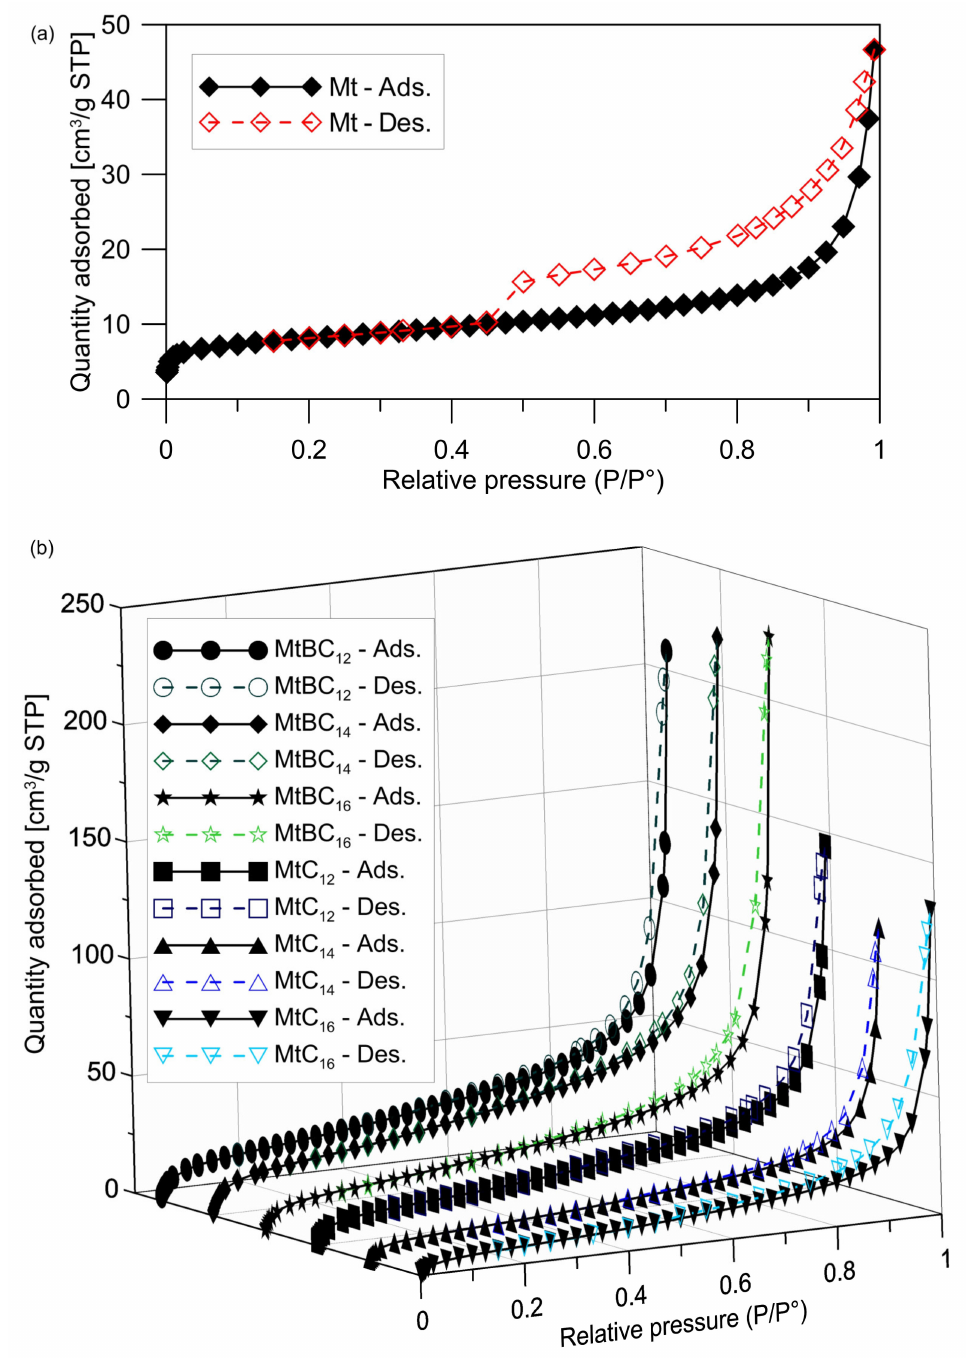
Figure 4. Comparison of N 2 adsorption and desorption isotherms at − 196 ◦ C: ( a ) raw montmorillonite; ( b ) montmorillonite intercalated with quaternary ammonium